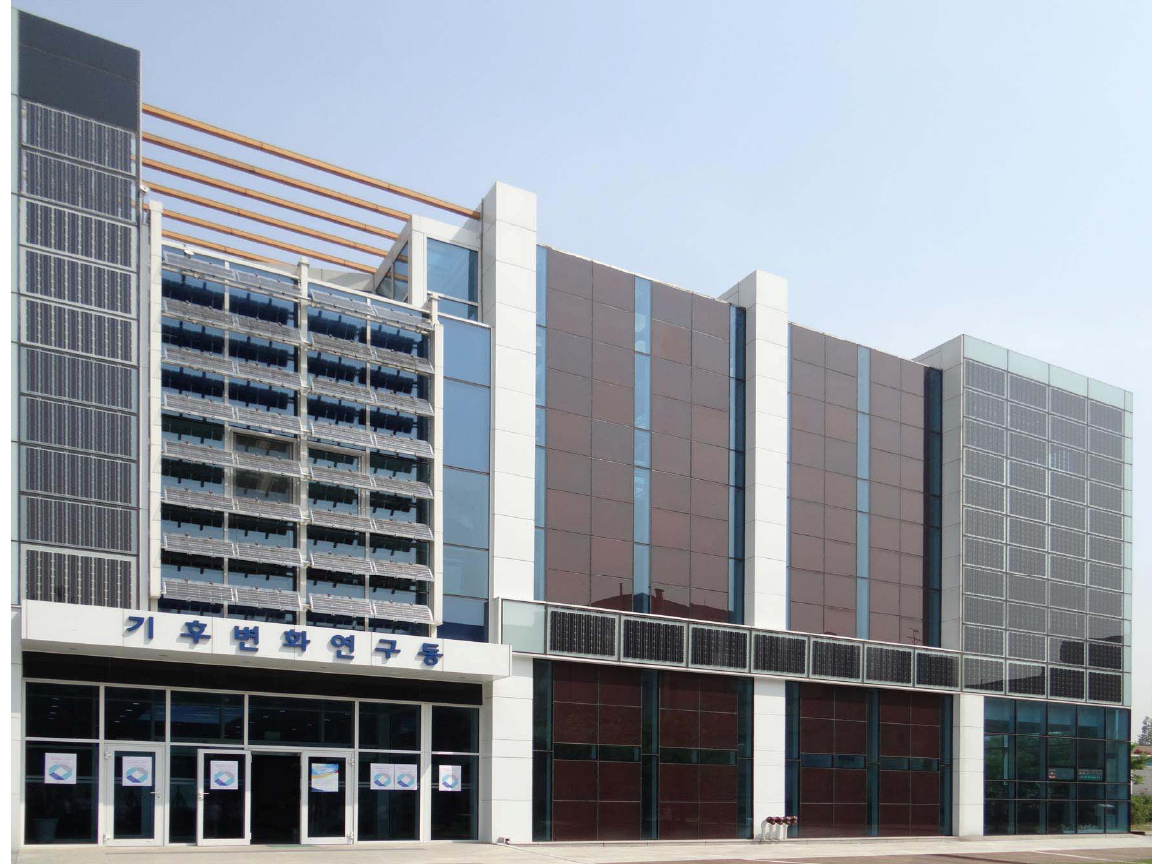
Figure 3. Formally and constructively integrated photovoltaic components with different cell technologies and appearance in the façade of the “Climate Change Research Building” in Incheon, South Korea. In this case components with crystalline silicon appear in dark blue and black color and components with thin film technology look dark